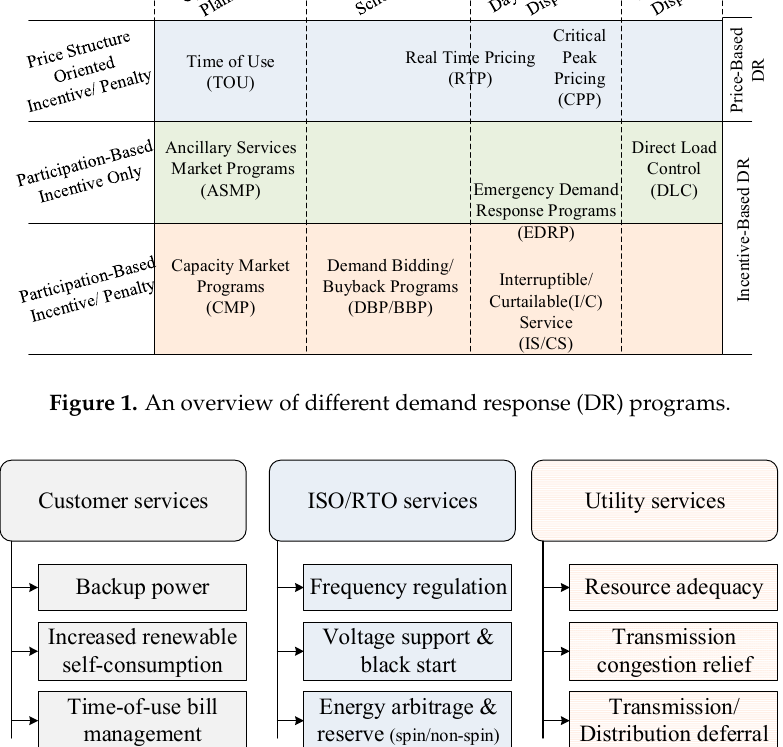
Figure 2. An overview of the benefits of a battery energy storage system (BESS).